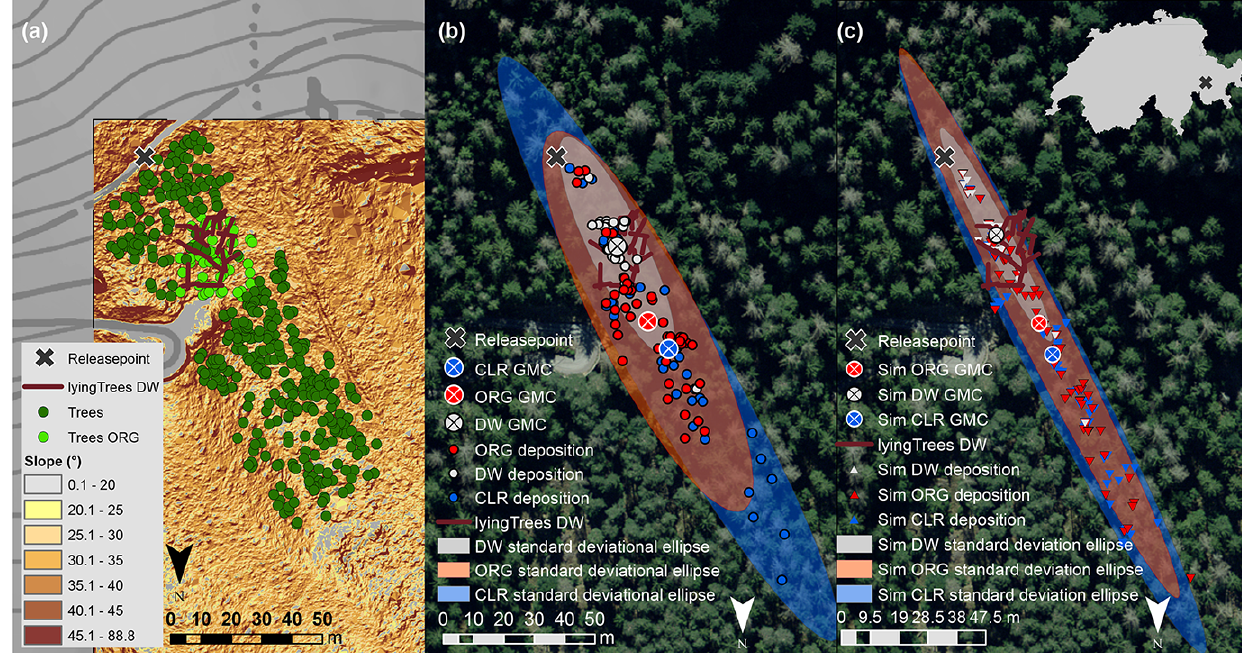
Figure 1. Overview of the experimental test site Surava: (a) slope map with the standing trees during the whole trilogy (dark green circles) and during the ORG state (light green circles) and lying deadwood during DW (brown lines). (b) Deposition points of all 111 runs of the 45kg EOTA 111 rocks including all three states of the forest: ORG in red, fresh DW in gray and CLR in blue. The corresponding geographic mean centers (GMC), are shown with cross symbols in the corresponding color. Additionally, the third standard deviation ellipses (SDEs) of each data set are depicted as transparent ellipses. (c) Deposition points of the 300 total simulated trajectories under consideration of the three states of the forest. The GMC and SDE are in the corresponding colors of the experimental results. Source of topographical map (a) and orthophoto (b, c) : Federal Office of